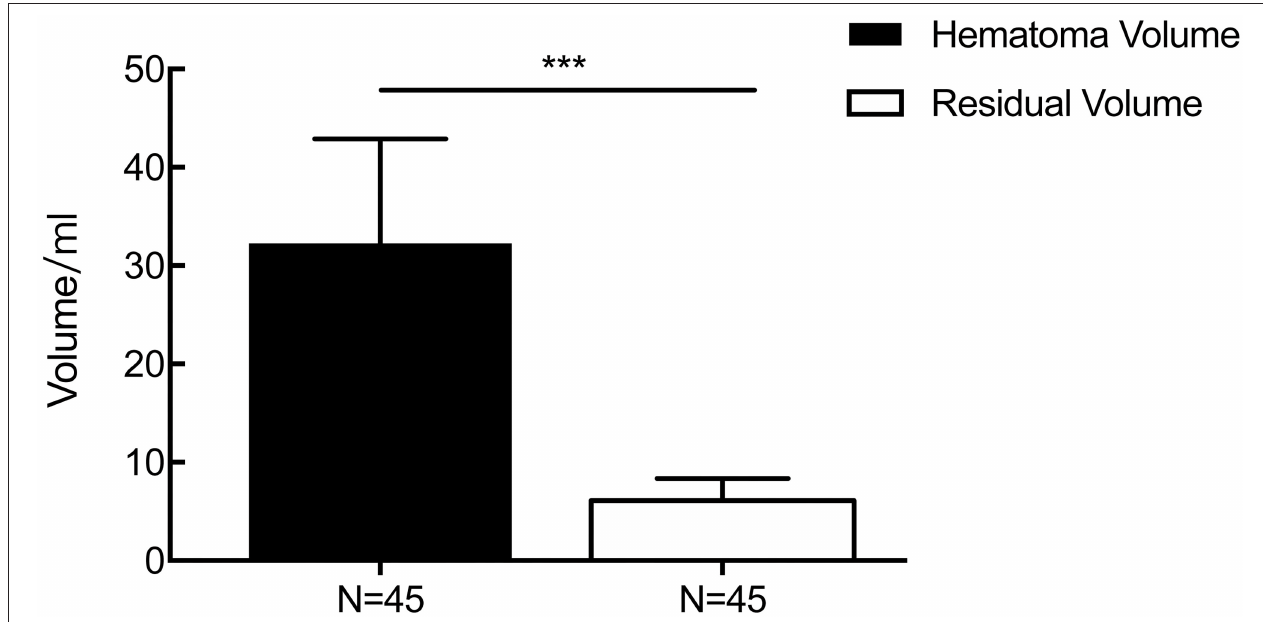
FIGURE 5 | The result of changes in the volume of the hematoma perioperatively. The mean hematoma volume was 32.27 ± 10.63ml before the operation, while the average left hematoma volume was 6.08 ± 2.27ml until the drainage tube was removed ( p < 0.001). *** p < 0.001.